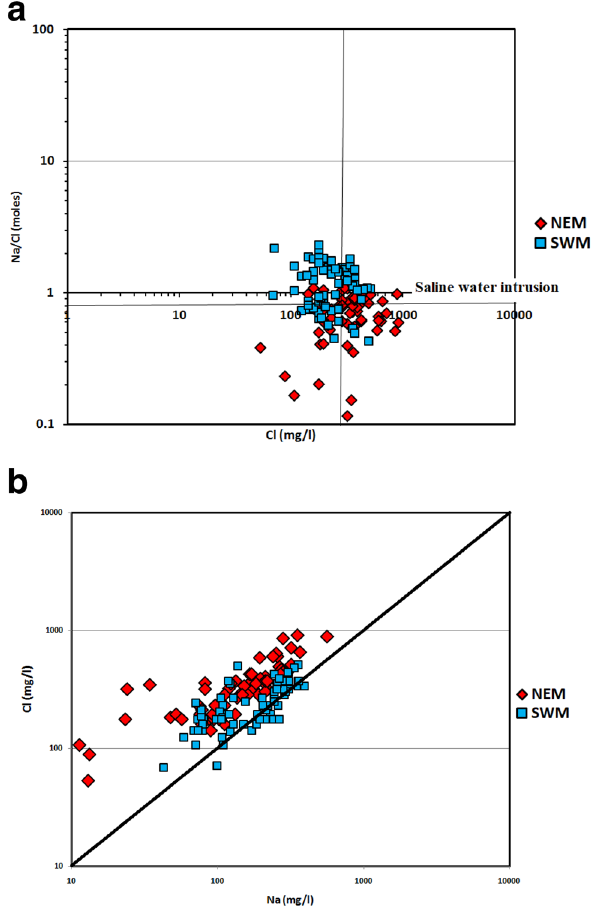
Fig. 11 a The relationship between the Na + /Cl − ratio and the Cl − values to determine the saline intrusion. b. The bivariate plot between the Na and Cl to determine the sea water intrusion pro-